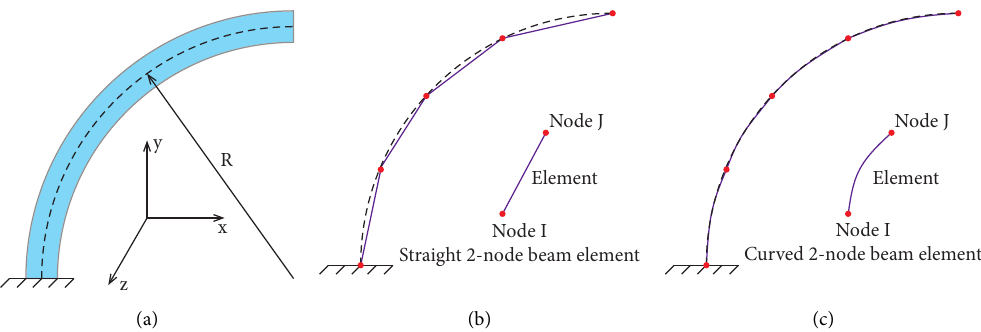
Figure 1: Schematic illustrations of a typical three-dimensional curved beam. (a) A quarter arc curved beam with radius R , divided by (b) the straight two-node beam element and (c) the curved two-node beam